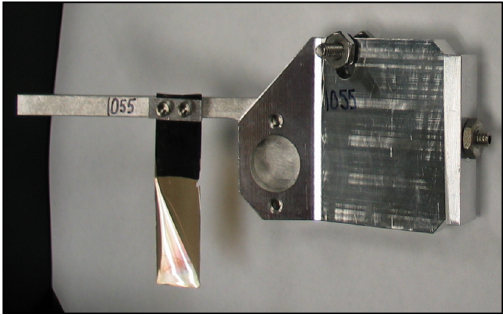
FIG. 14. The 3rd generation foil assembly before use